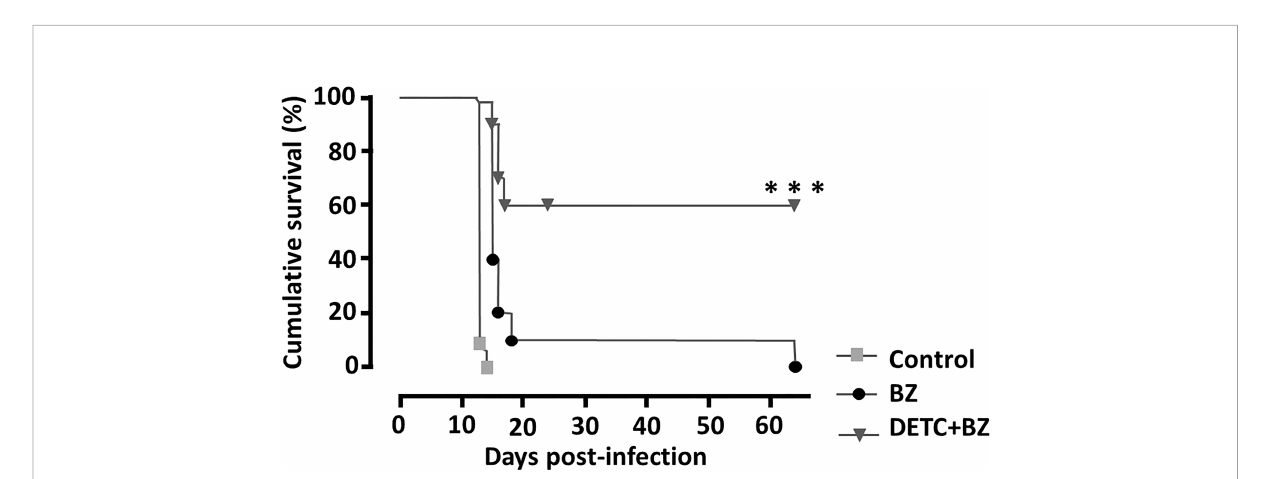
FIGURE 12 Monitoring the cumulative survival of mice infected intraperitoneally with 10 4 T. cruzi blood trypomastigote/mL (Y strain) of and treated with 10 mg/ kg/day of DETC and BZ alone or in combination, p.o. daily for 60 consecutive days. Note that animals treated with the combination had a survival rate of 60%, whereas the group treated with BZ was 10% and the control group died on the 14 th day. *** p < 0.001 ANOVA and Tukey